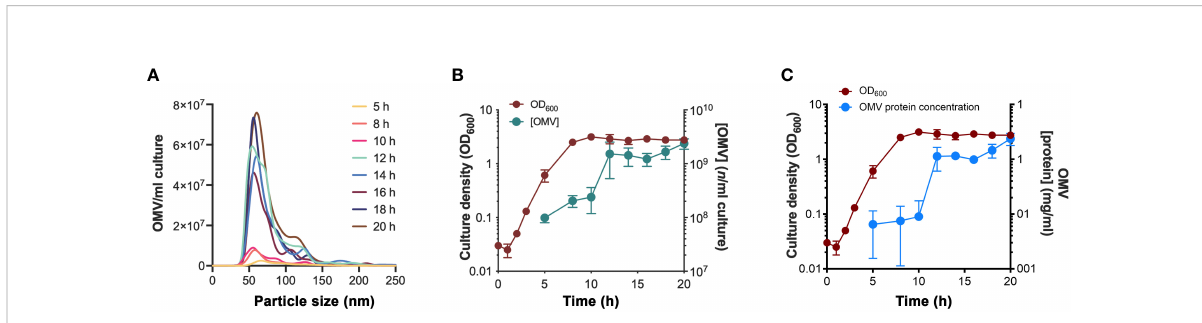
FIGURE 1 Vesiculation dynamics of H. in fl uenzae at different growth phases. (A) Nanoparticle tracking analysis showing the size distribution of H. in fl uenzae 3655 OMVs obtained at various growth phases. One replicate from three independent experiments is shown. (B) OD measurements of the growth of H. in fl uenzae 3655 in liquid brain heart infusion (BHI) media and the corresponding levels of OMVs puri fi ed from the culture supernatant at indicated time points. (C) Protein concentration of the puri fi ed OMV samples in relation to the growth curve. The mean values and standard deviations from three independent experiments are plotted in panel (B, C)